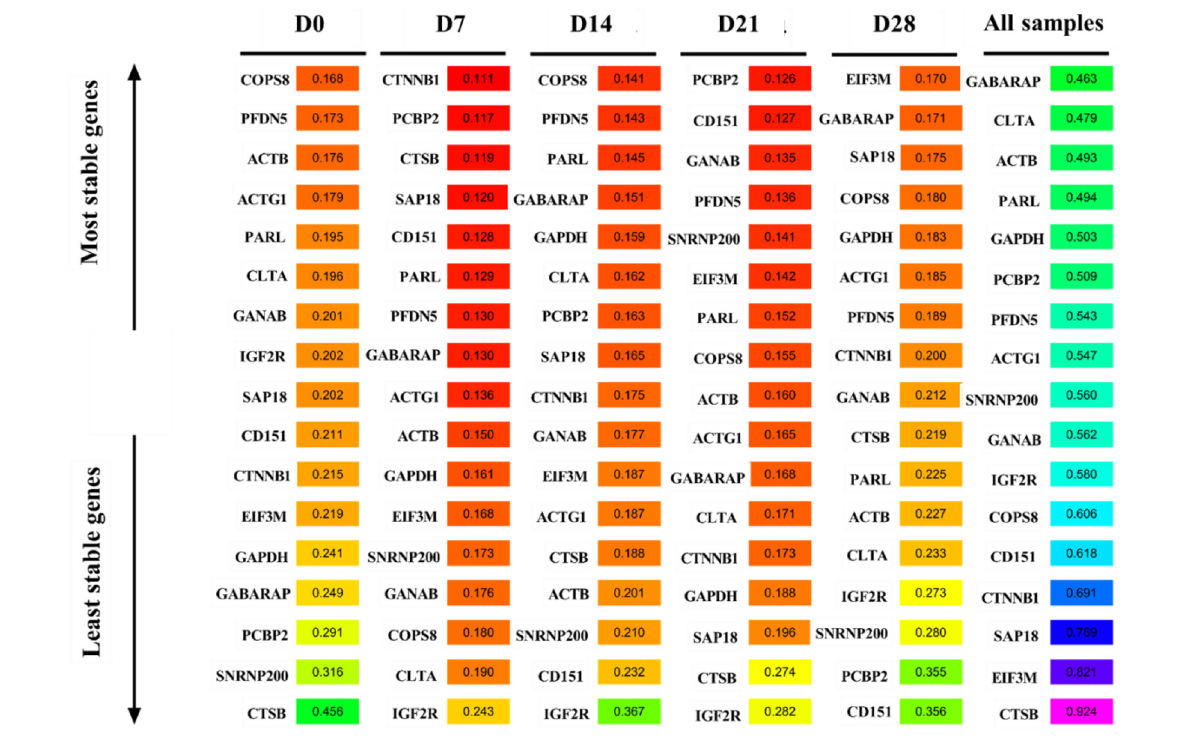
FIGURE7 1 Ct method analysis the expression stability of candidate reference